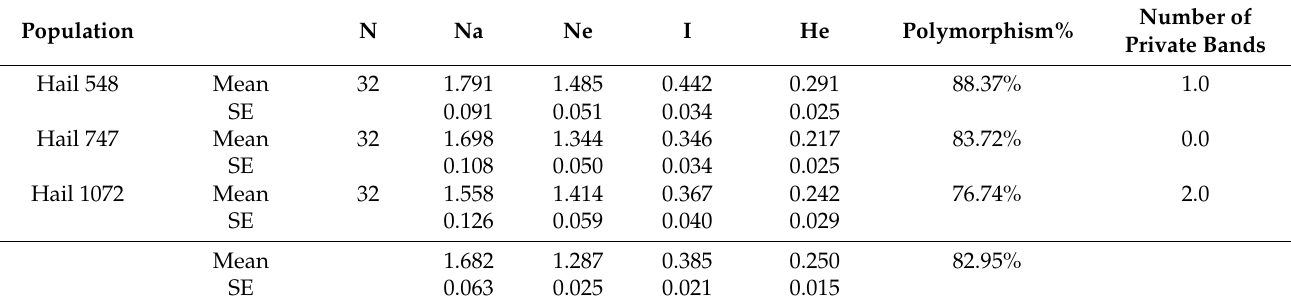
Table 2. Genetic diversity parameters for Hail tomato landraces using seven SRAP primer combinations. Population